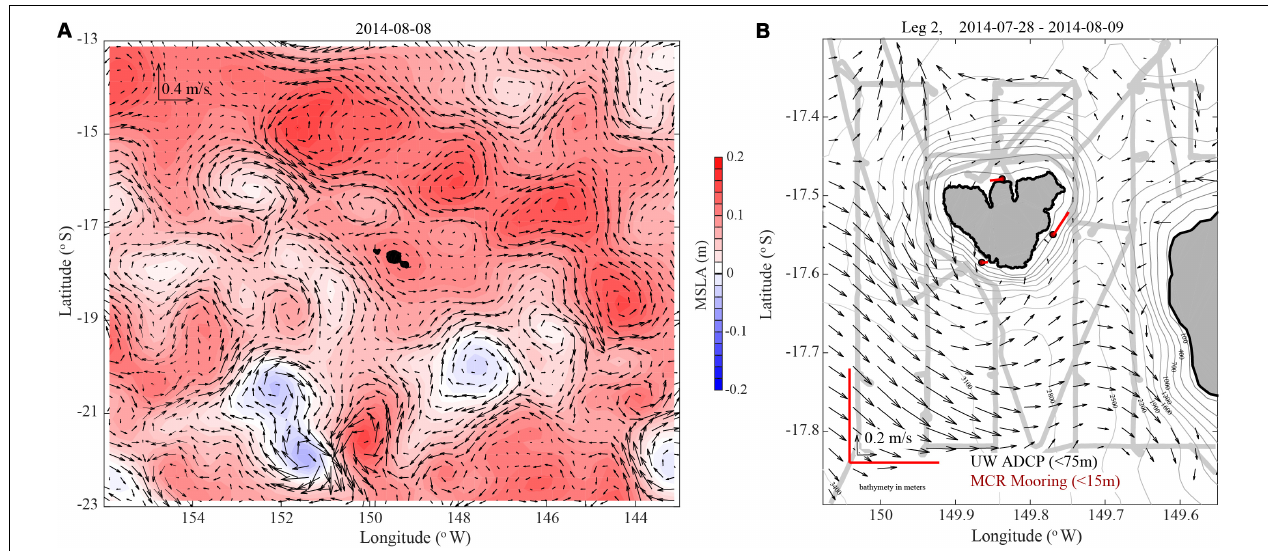
FIGURE 5 | Surface current patterns in the vicinity of Mo’orea. (A) Large-scale currents from 8 August 2014 from satellite radar altimetry http://marine.copernicus.eu/. Velocity scale for current vectors is at upper left. Color bar at right of panel indicates mean sea level anomaly (MSLA). (B) Currents around Mo’orea. Black vectors show optimally interpolated currents from a shipboard ADCP during 28 July–9 August 2014 as described in the text. Red current sticks near Mo’orea show vertically averaged currents from three bottom-mounted ADCPs on the 15 m isobath during 28 July–9 August 2014. Velocity scales at lower left correspond to ADCP vectors (black arrows) and moored currents (red sticks). Gray line shows ship track during ADCP data collection.